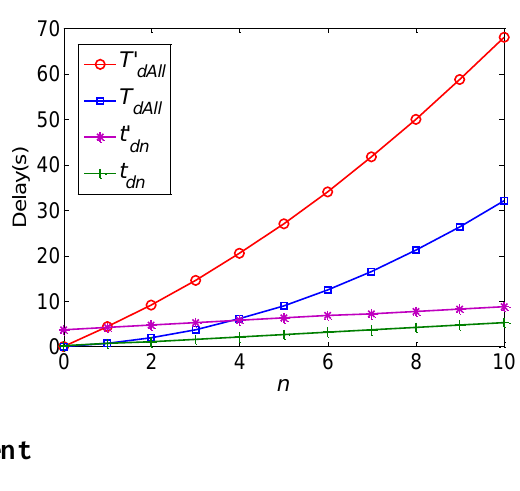
Figure 10. Calculated results of